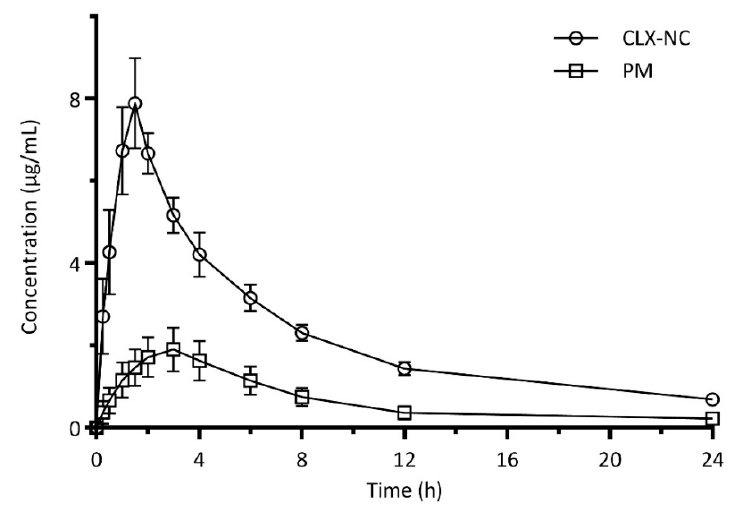
Figure 10. Plasma concentration-time curves of optimized CLX-NC and physical mixture (PM) in rats after oral administration(mean ± SD, n = 6). Table 5. Pharmacokinetic parametersof optimized CLX-NC andPM after oral administration(mean ± SD, n = 6).